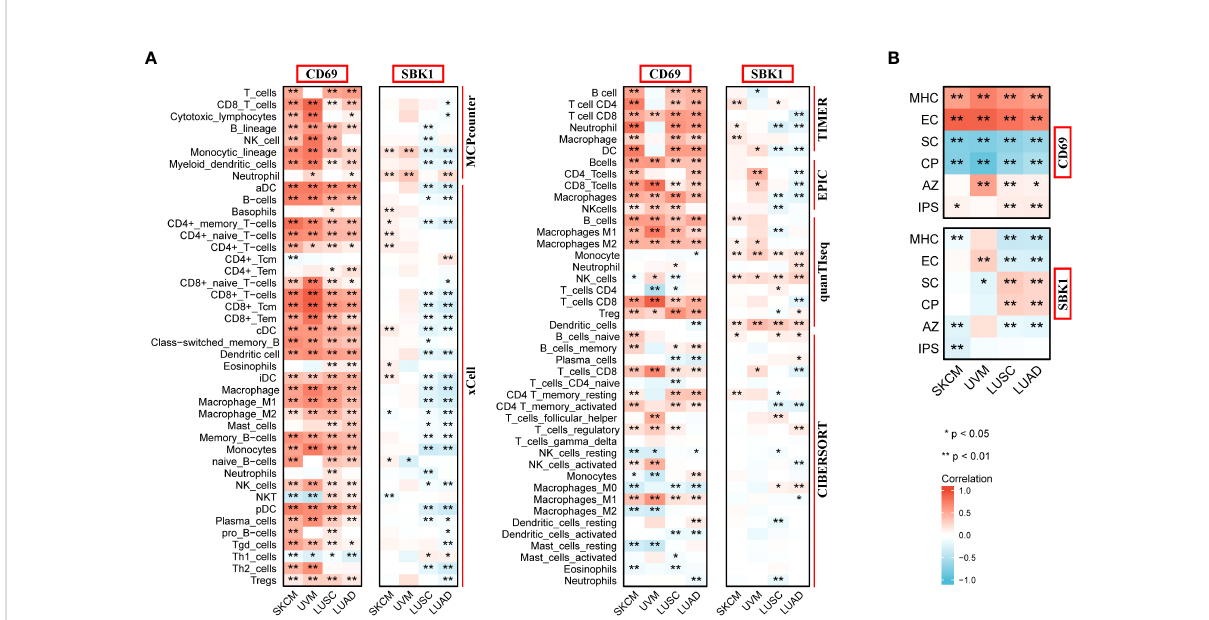
FIGURE 6 Analysis of correlation between the levels of CD69 and SBK1 , and in fi ltrating immune cells and IPS. (A) CD69 positively correlates with various immune cells in SKCM, UVM, LUSC and LUAD, while SBK1 negatively correlates with various immune cells in Lung Cancer related cohorts LUSC and LUAD. (B) CD69 levels positively correlate with IPS in SKCM, LUSC and LUAD, while SBK1 levels negatively correlate with IPS in SKCM. MHC, major histocompatibility complex; CP, immune checkpoints; EC, effector cells; SC, suppressor cells; AZ, average z-scores. * indicates p<0.05. ** indicates